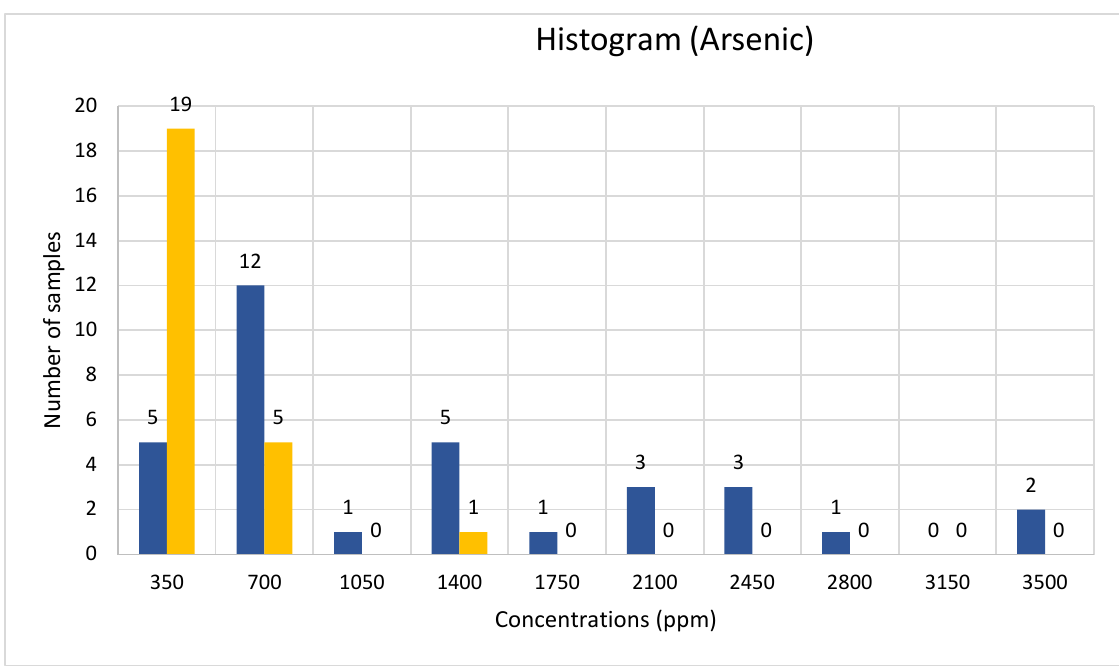
Figure 5. Histogram of arsenic concentrations (mining area in blue and waste rock in orange). A similar distribution occurs for antimony displays in Figure 6.